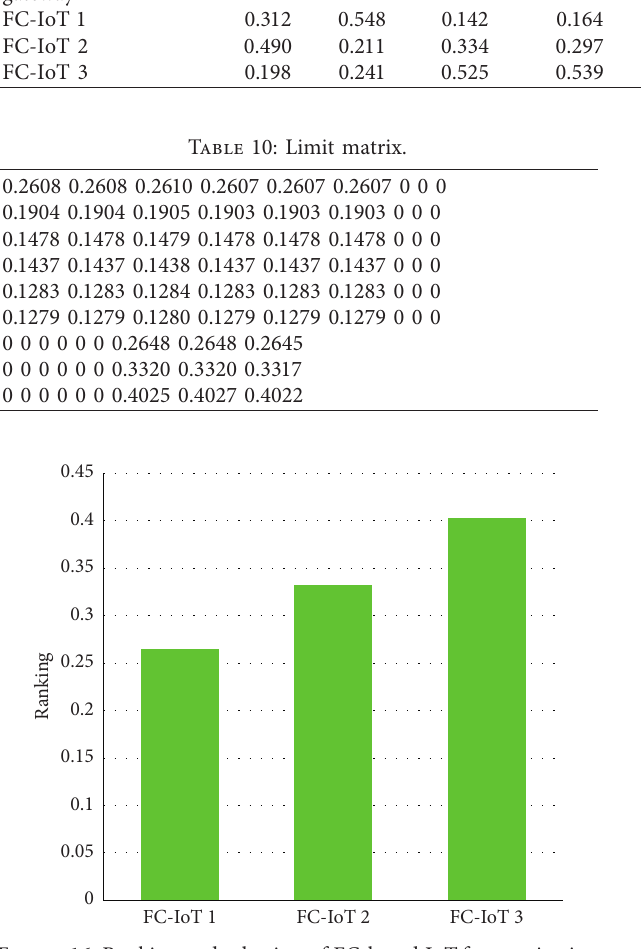
Figure 16: Ranking and selection of FC-based IoT for monitoring of